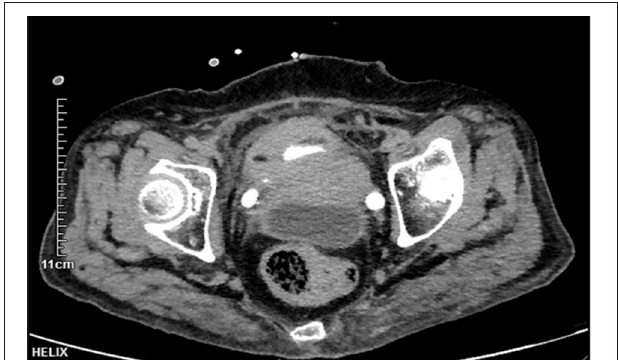
FIGURE 2 | Coronal section CT urography of case 2. The bladder was filled with a contrast agent. The wall of the bladder was thickened. The CT scan demonstrated free fluid and thick-wall cysts in the pelvic cavity behind the uterus.